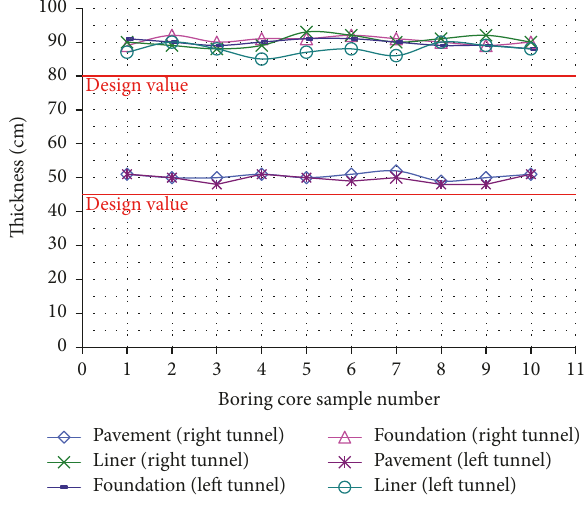
Figure 10: Thickness detection results. Table 5: Grade determination of void behind the liner.